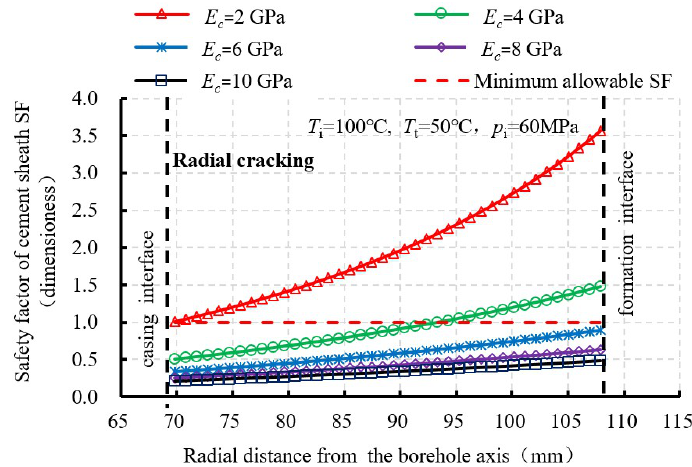
Figure 15. Radial distribution of the cement sheath safety factors for radial cracking under a different elasticity modulus of cement sheath.